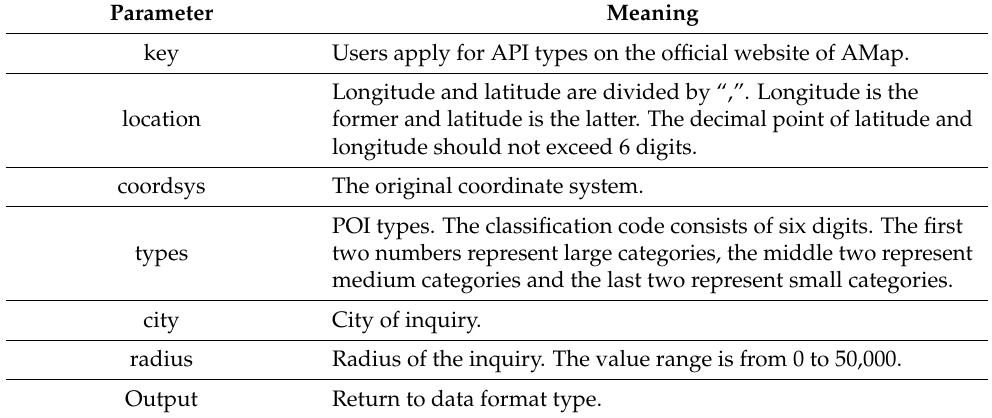
Table 1. Coordinate conversion and peripheral searching parameters using Amap